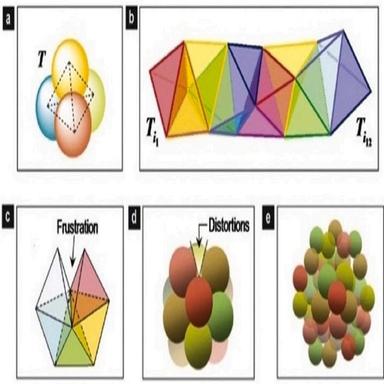
(a) Four spheres forming tetrahedral unit, (b) longitudinal chain of tetrahedra-Coxeter helix, (c) compact cluster of tetrahedrons with distortion, (d) homogeneous distribution of distortions in icosahedral packing of spheres, and (e) multiple cracking in the most-outer shell of packed spheres. Reprinted (adapted) with permission from (ACS Nano 2010; 4 (8); 4717–4724). Copyright © 2010, American Chemical Society.